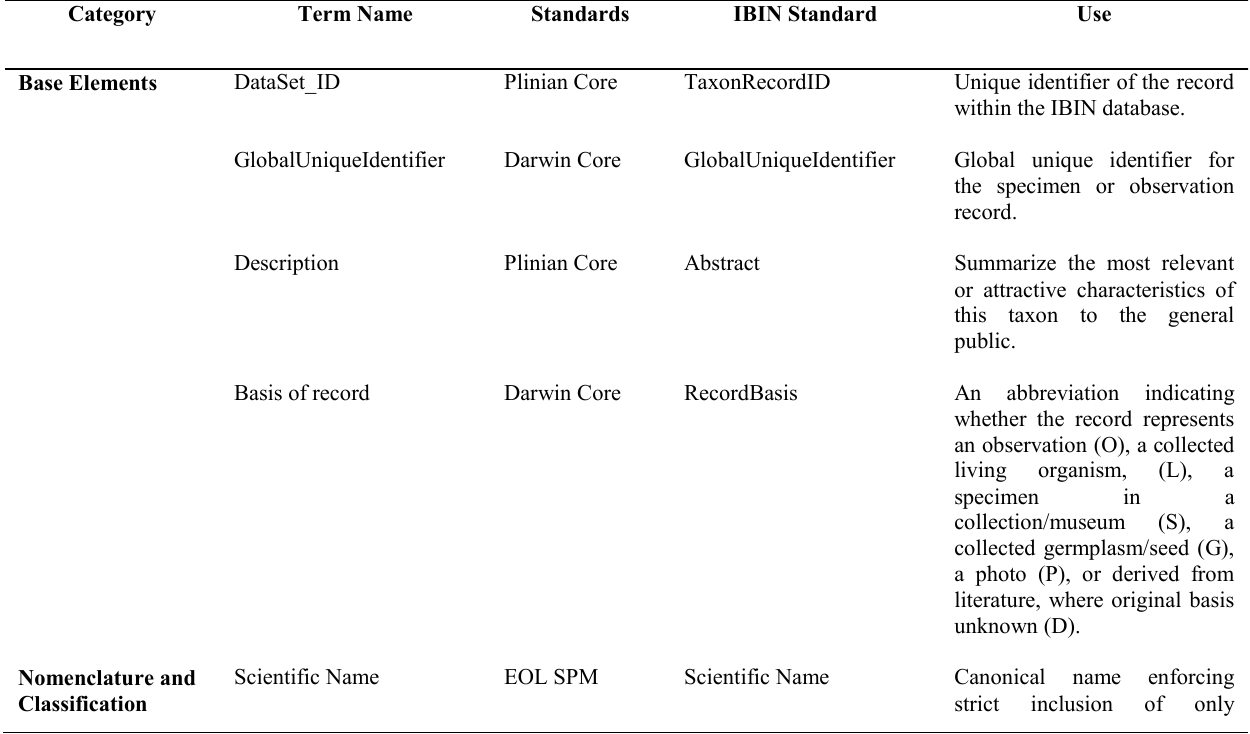
Table3. Mapping of Different Standards into IBIN Schema